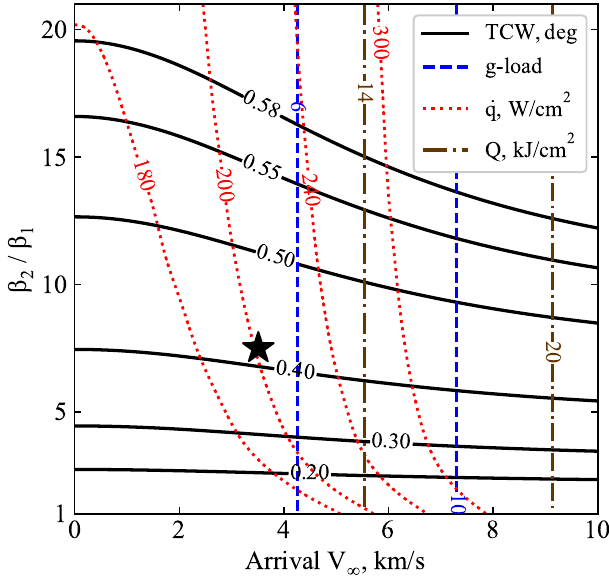
Figure 16. Venus drag-modulation aerocapture feasibility chart with β 1 = 20 kg/m 2 , R N = 0.235 m, target apoapsis = 2000 km. The star indicates the selected baseline β 2 / β 1 = 7.5 and V ∞ = 3.51 km/s.